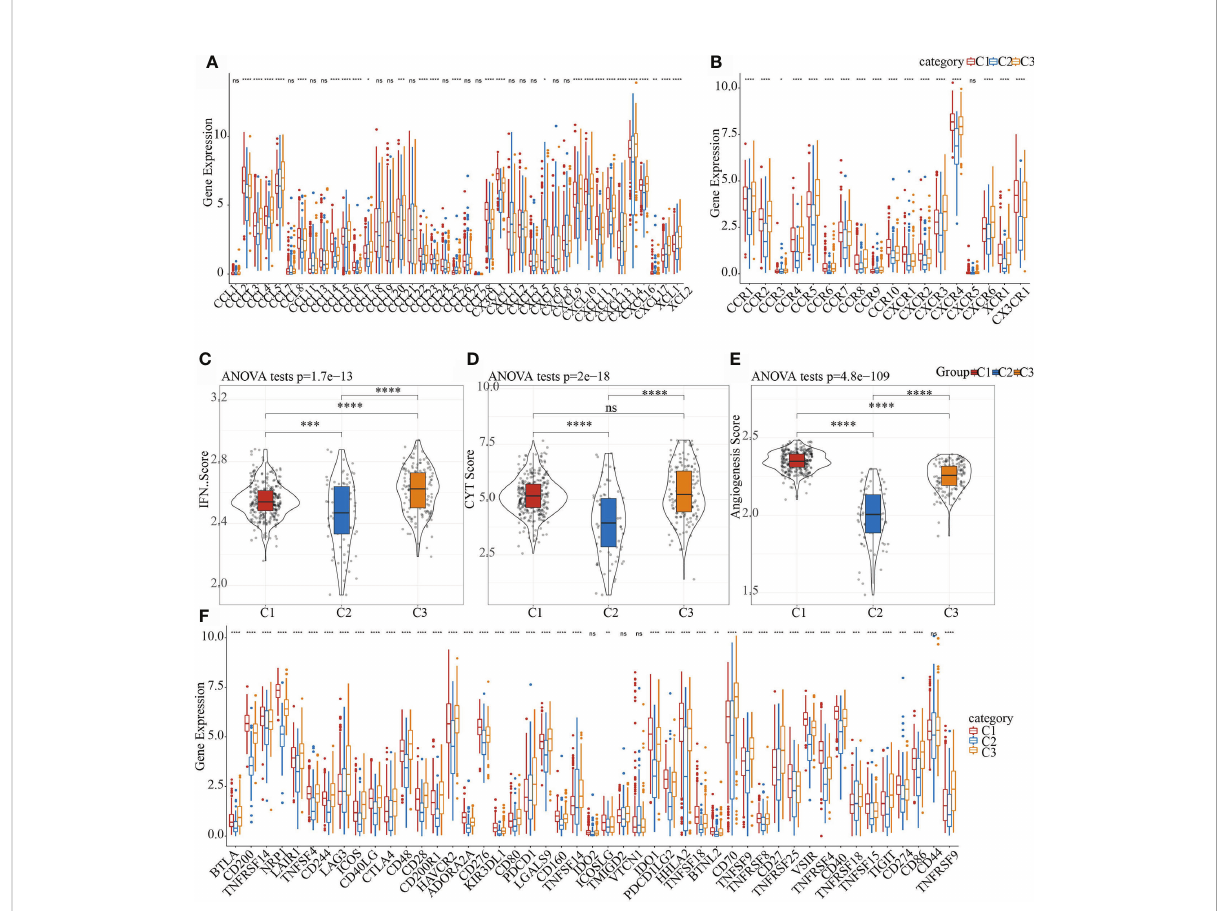
FIGURE 6 Differences in the distribution of chemokines, IFN g scores, immune T cell cytolysis activity, angiogenesis scores, and immune checkpoint genes in different subgroups. (A) Difference in the expression and distribution of chemokines in the TCGA cohort; (B) Difference in the expression and distribution of chemokine receptors in the TCGA cohort; (C) Difference in the distribution of IFN g scores in different subgroups in the TCGA cohort; (D) Differences in immune T cell cytolysis activity in different subgroups; (E) Differences in angiogenesis scores in different subgroups; (F) Differences in the expression and distribution of immune checkpoint genes in the TCGA cohort; the signi fi cance was tested by analysis of variance, * means p< 0.05; ** means p< 0.01, *** means p< 0.001, **** means p< 0.0001, ns, not signi fi